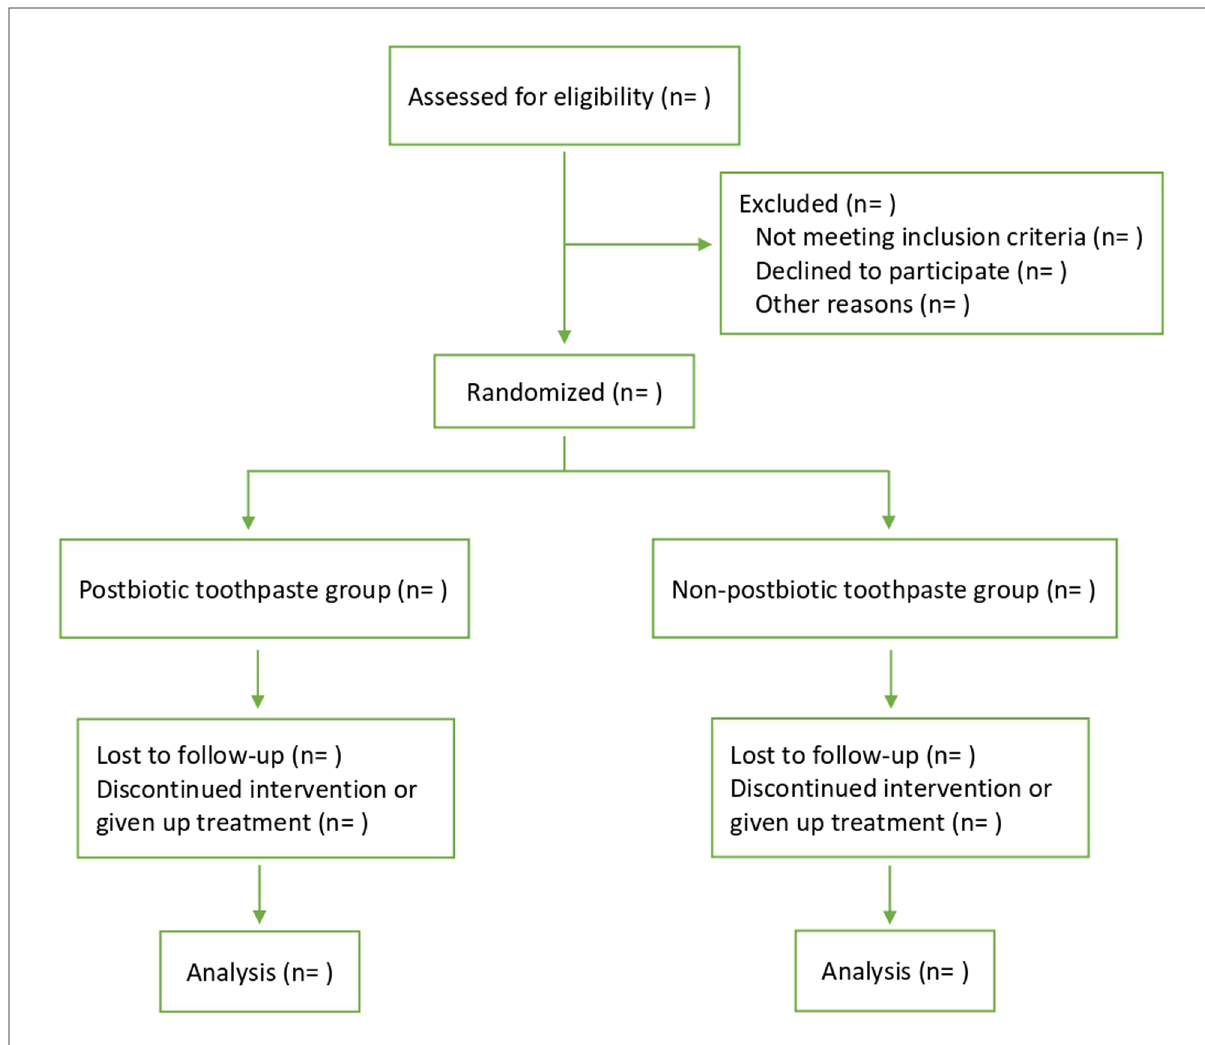
FIGURE 1 Study design fl ow